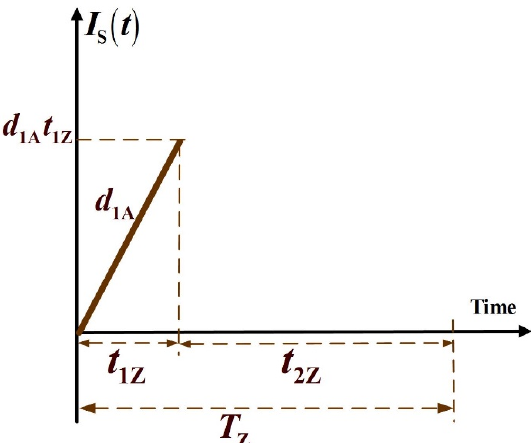
Fig. 6. The scrap product level in condition